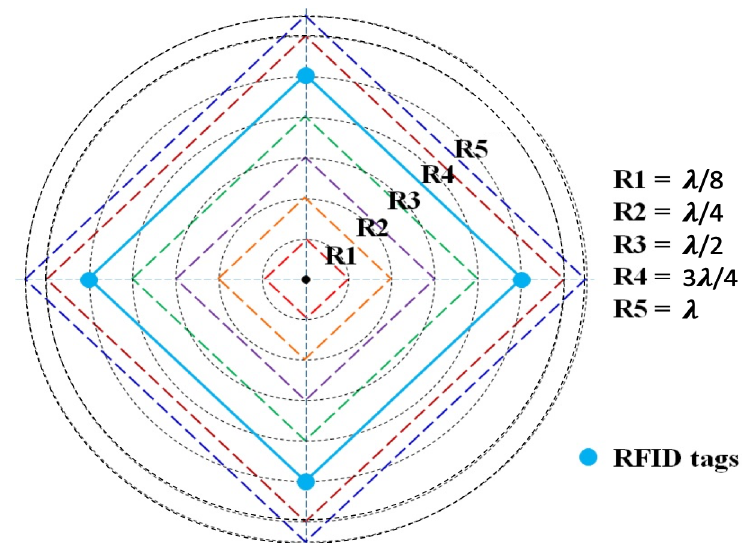
ff erent radii for the constellation of Figure 6. Different radii for the constellation of tags. Figure 6. Di Figure 6. Different radii for the constellation of tags.